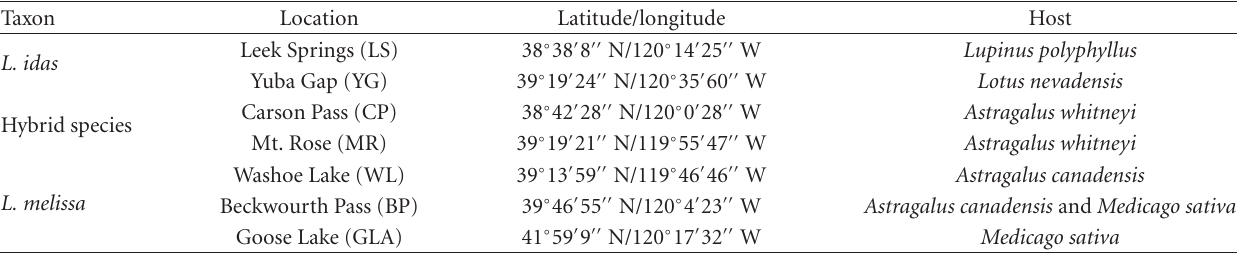
Table 1: Locations of populations (see also Figure 1) and hosts associated with the seven populations studied.